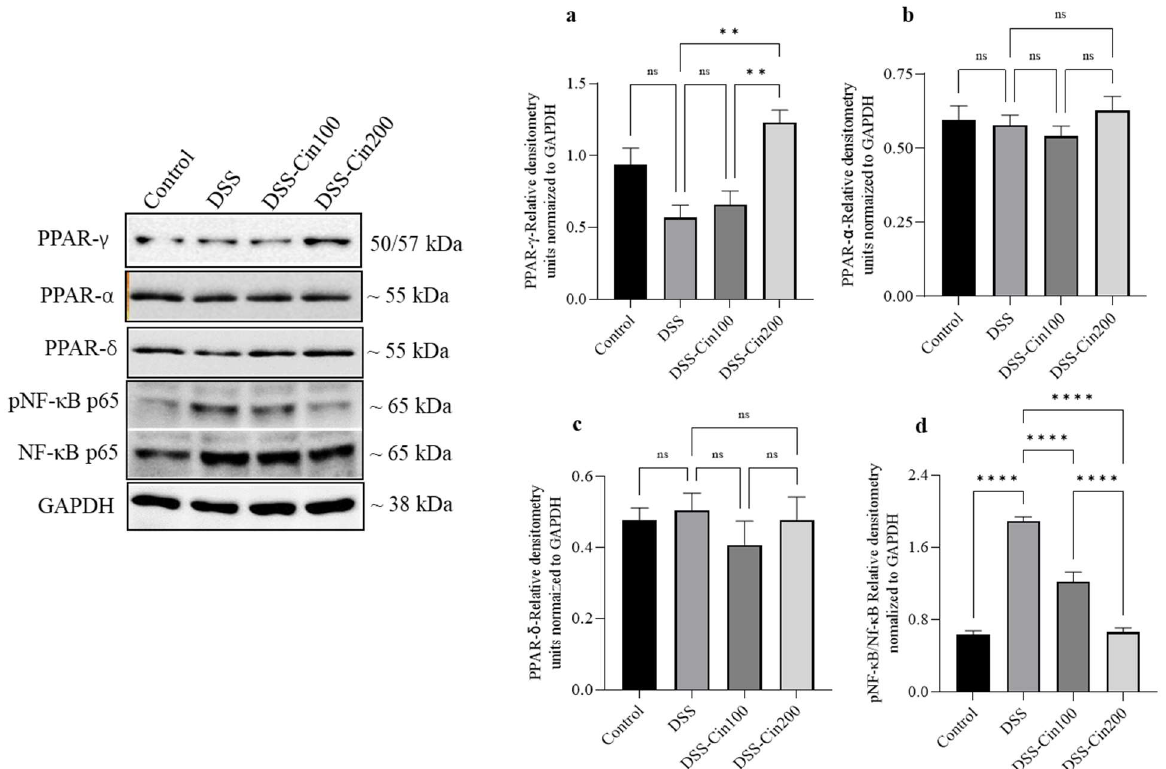
Figure 7. Effect of 1,8-cineole on PPAR γ , PPAR α , PPAR δ , and pNF κ B/NF κ B protein expression. ( a ) The side panel shows PPAR γ , PPAR α , PPAR δ , and pNF κ B/NF κ B protein expression. Protein bands were normalized to the GAPDH protein internal control as shown. DSS administration significantly ( b ) decreased PPAR γ expression and 1,8 cineole at the higher concentration ( b ) increased it above the control. DSS administration and 1,8-cineole treatment ( c , d ) did not alter PPAR α and PPAR δ expression. DSS administration markedly increased the phosphorylation of NF κ B, while 1,8-cineole treatment at the higher concentration prevented this. Data were obtained from n = 4 animals. The results are expressed as the means ± SEM. ** p ≤ 0.01, **** p ≤ 0.0001, and ns indicates results that were not